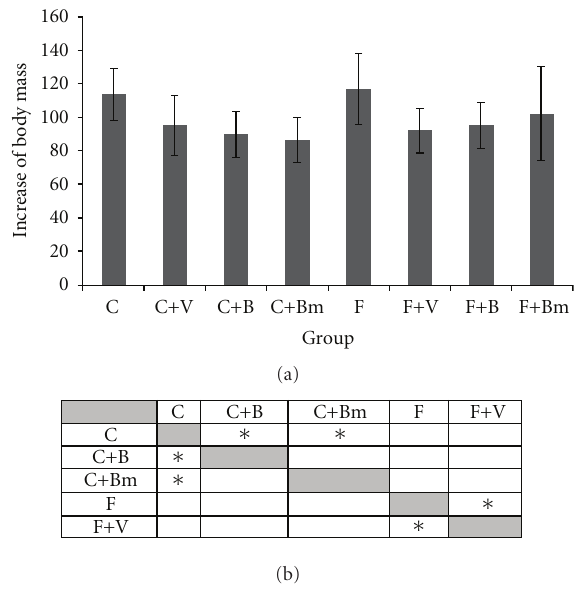
Figure 1: Values of animal weight changes of animals fed with a standard diet and high fatty diet ( P ≤ 0.2005) with the addition of vanadium complexes tested. Data presented as mean ± SD for n = 6. (b) Statistical di ff erences between groups P < 0.05.